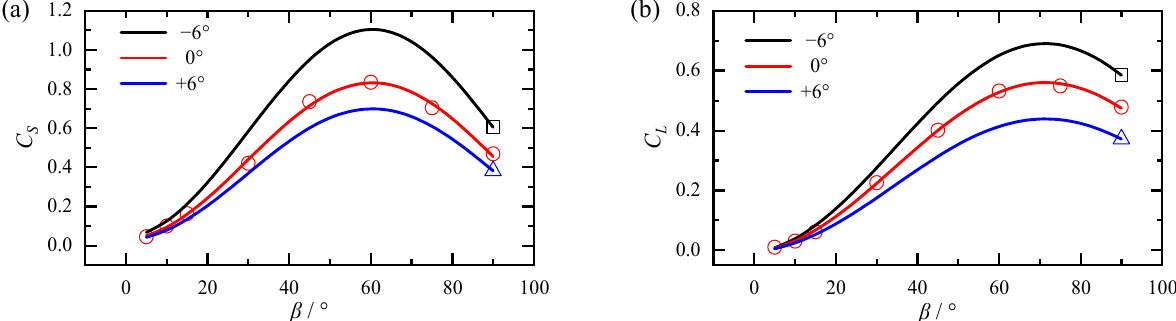
Figure 14. Aerodynamic coefficients of the head car at different wind attack angles: ( a ) side coeffi- cients; ( b ) lift coefficients.